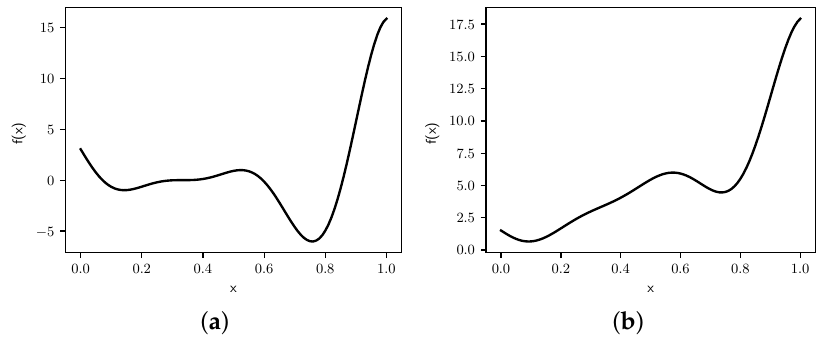
Figure 7. Graphs of ( a ) f 1 ( x ) and ( b ) f 2 ( x )